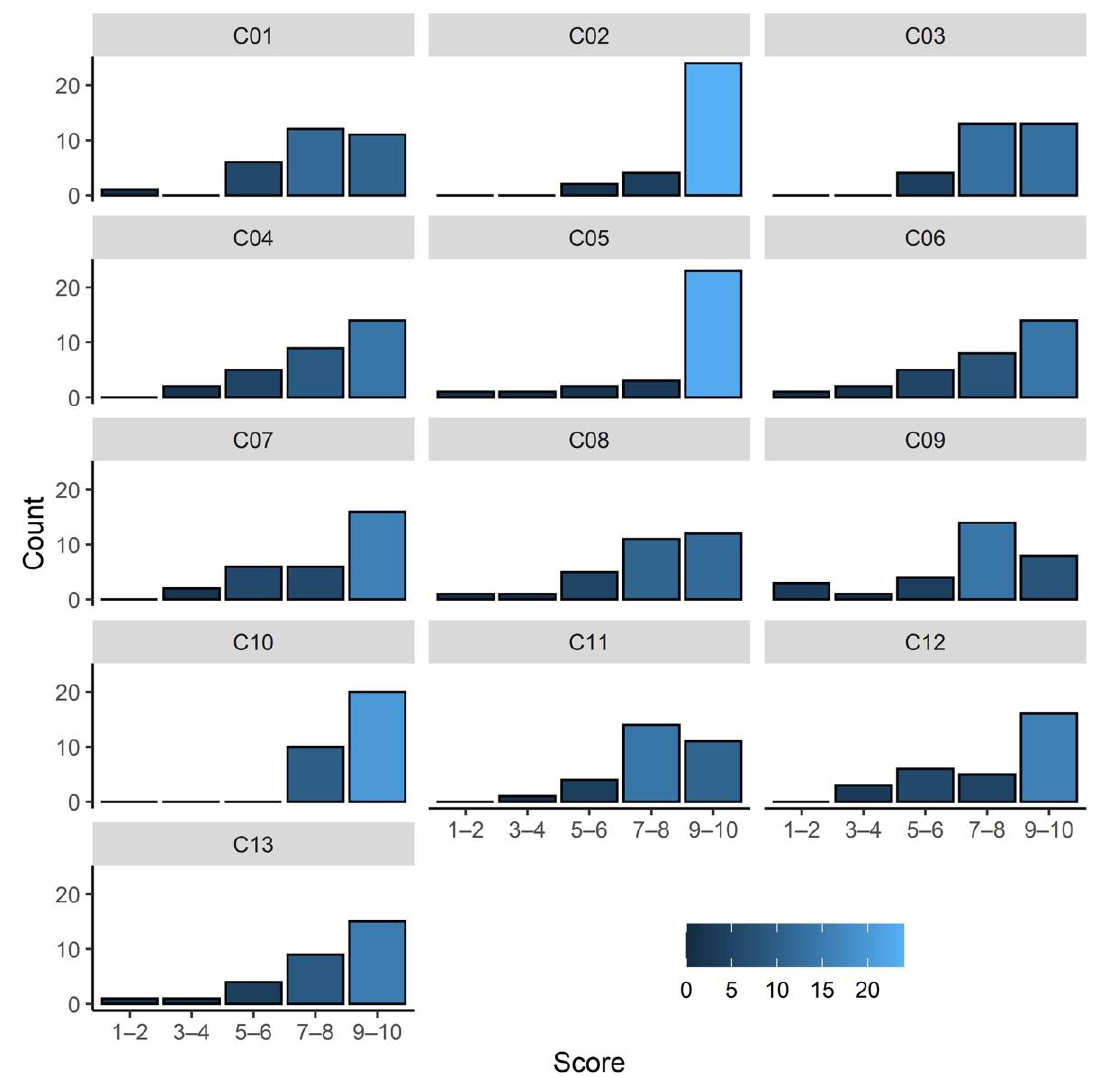
Figure 4. Frequency of distribution of the degree of importance for the 13 proposed criteria.